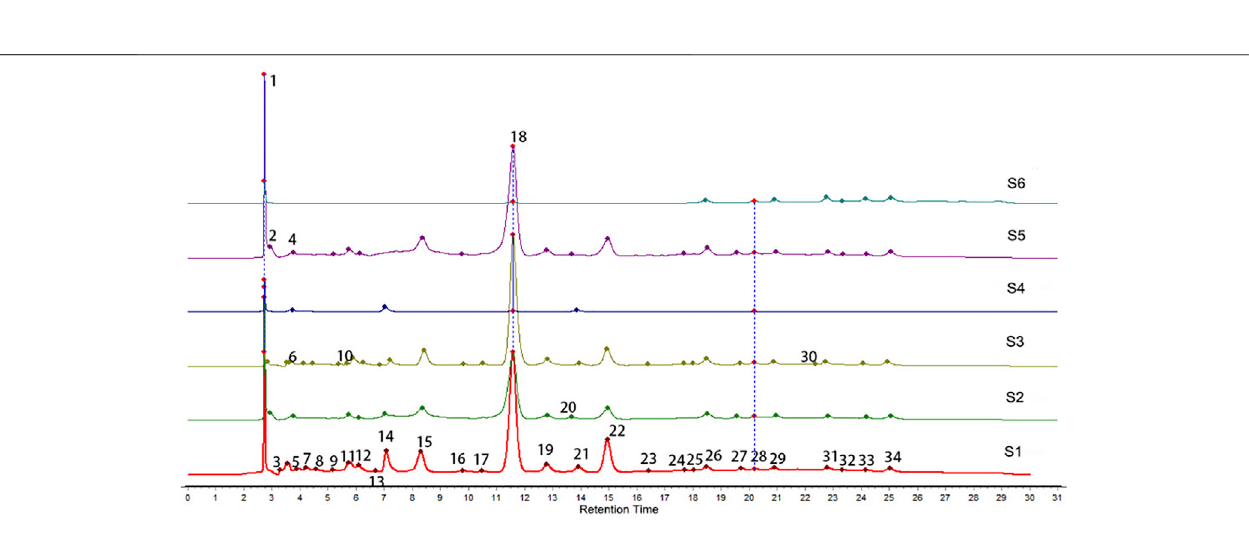
FIGURE 2 | HPLC chromatogram overlay and feature peaks of six extracts.